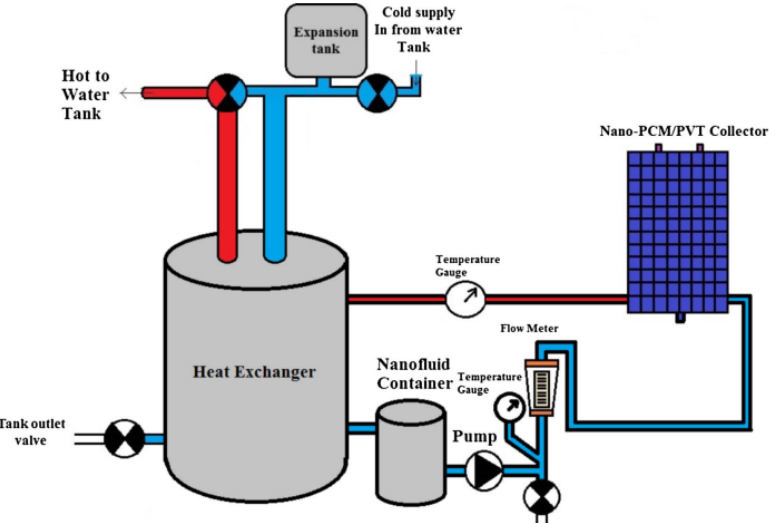
Figure 16. Schematic description of the experimental system studied by Al-Waeli et al. [61]. Adapted with permission from Elsevier.